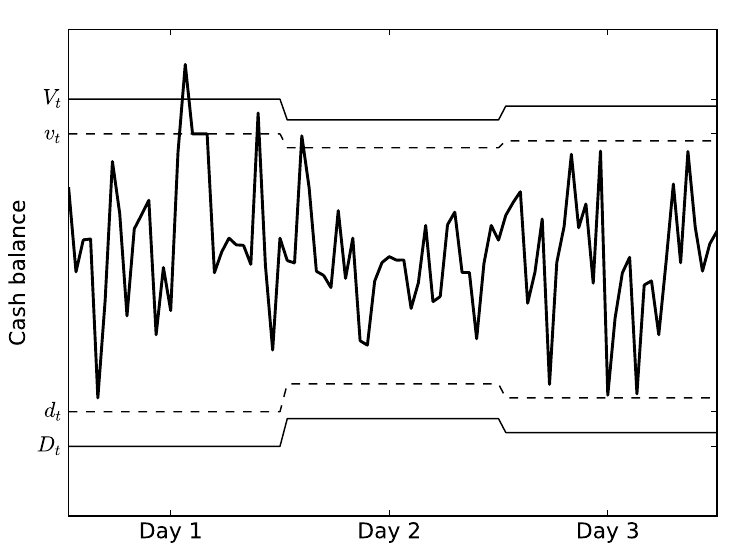
Fig. 6 The Dynamic Simple Policy of